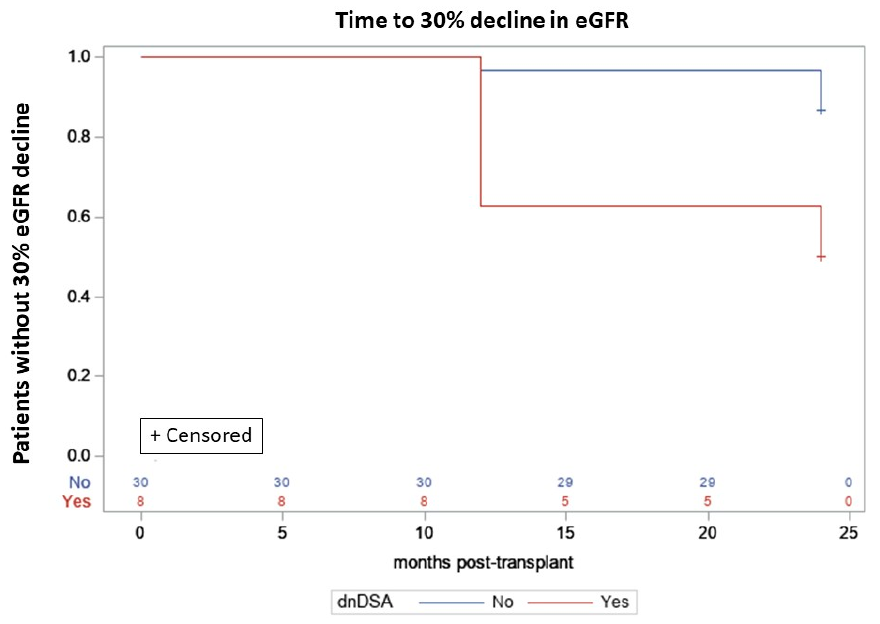
Figure 2. Probability of the decrease of eGFR < 30% from baseline in the dnDSA- positive and the dnDSA- negative patients from a prospective group, log rank p = 0.0129.